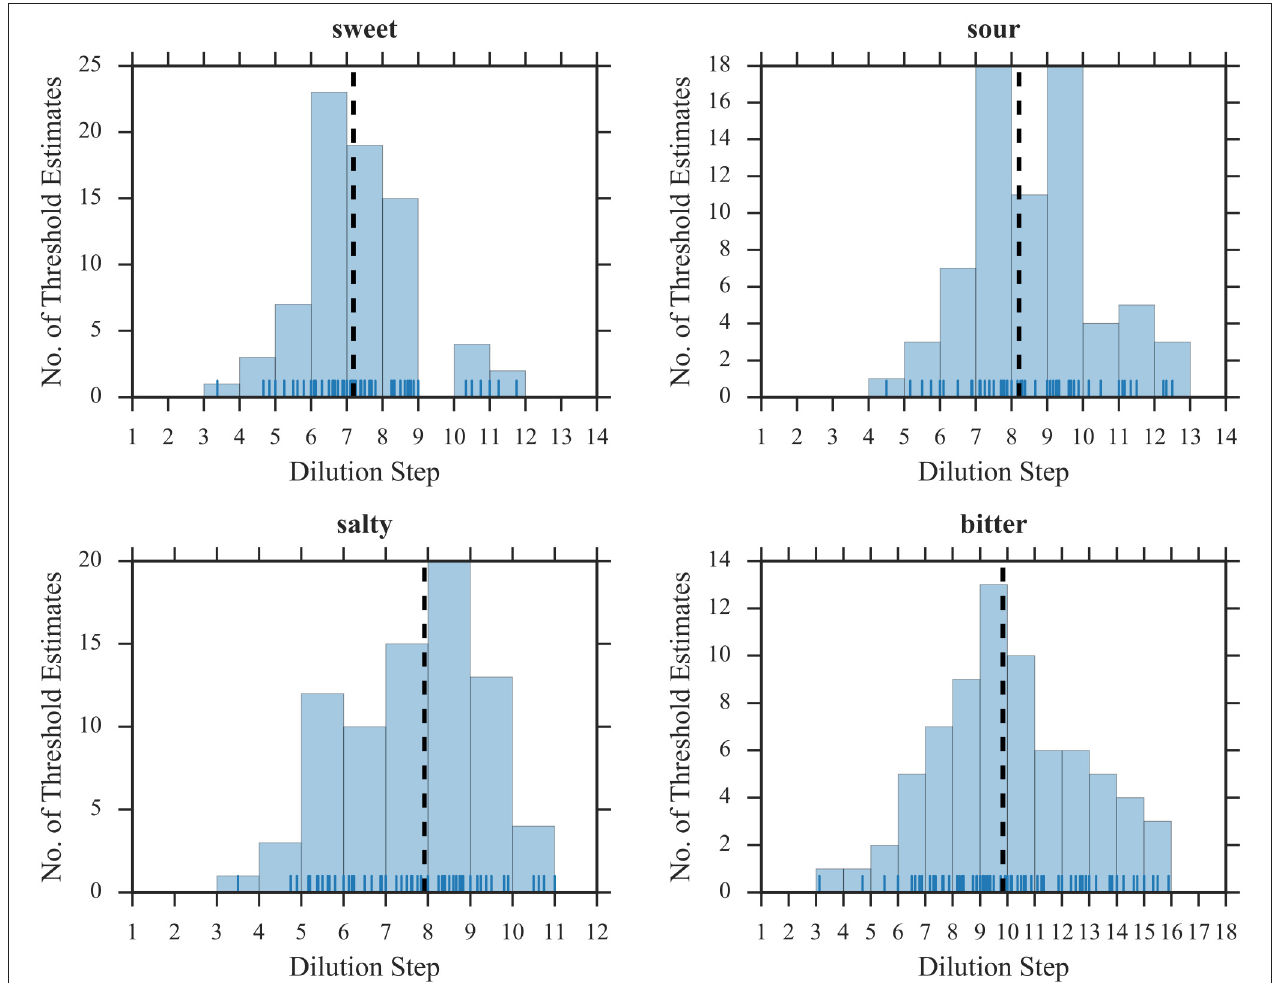
FIGURE 1 | Distribution of threshold estimates for SIAM. Blue vertical lines depict individual participants; black dashed lines represent the medians.